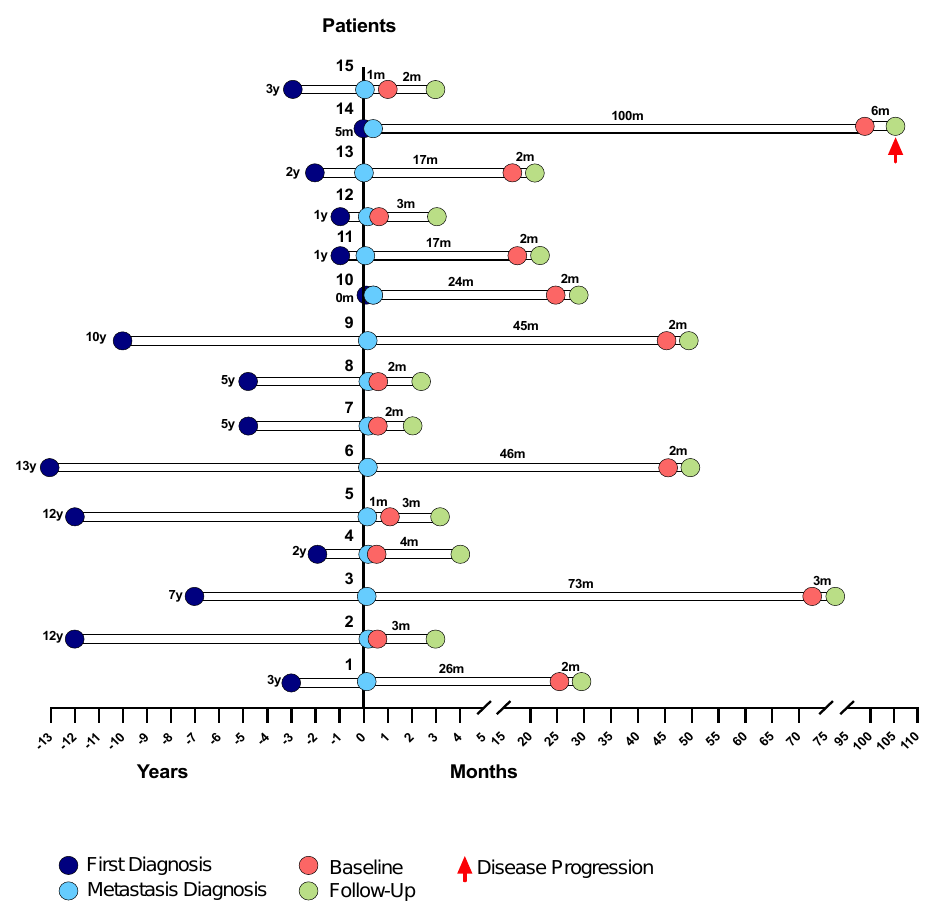
Figure 11. Representative chronogram of the different moments under study, namely: metastasis diagnosis, baseline collection and subsequent follow-up collection, for each patient.